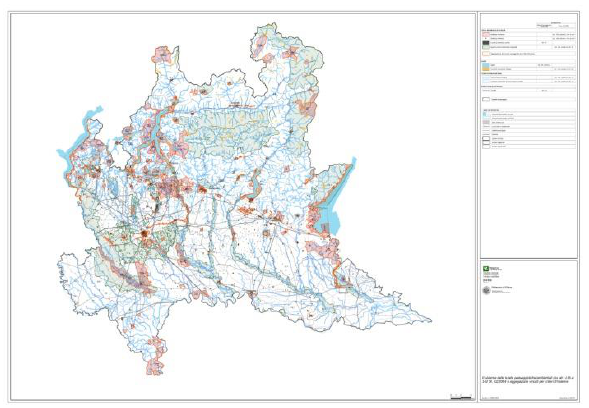
Figure 3. Lombardy PPR, review: the aggregations of bonded areas and sites (in red) in order to define landscape preservation extensive criteria involving a system of protected areas, often geographically connected and referring to Landscape settings (in black). Lombardy landscape preservation must be joined with planning policies and practices: for this reason before preparing a single criteria for each bonded area, the Lombardy PPR review issues extensive preservation management criteria, referring to a system of protected areas, often geographically